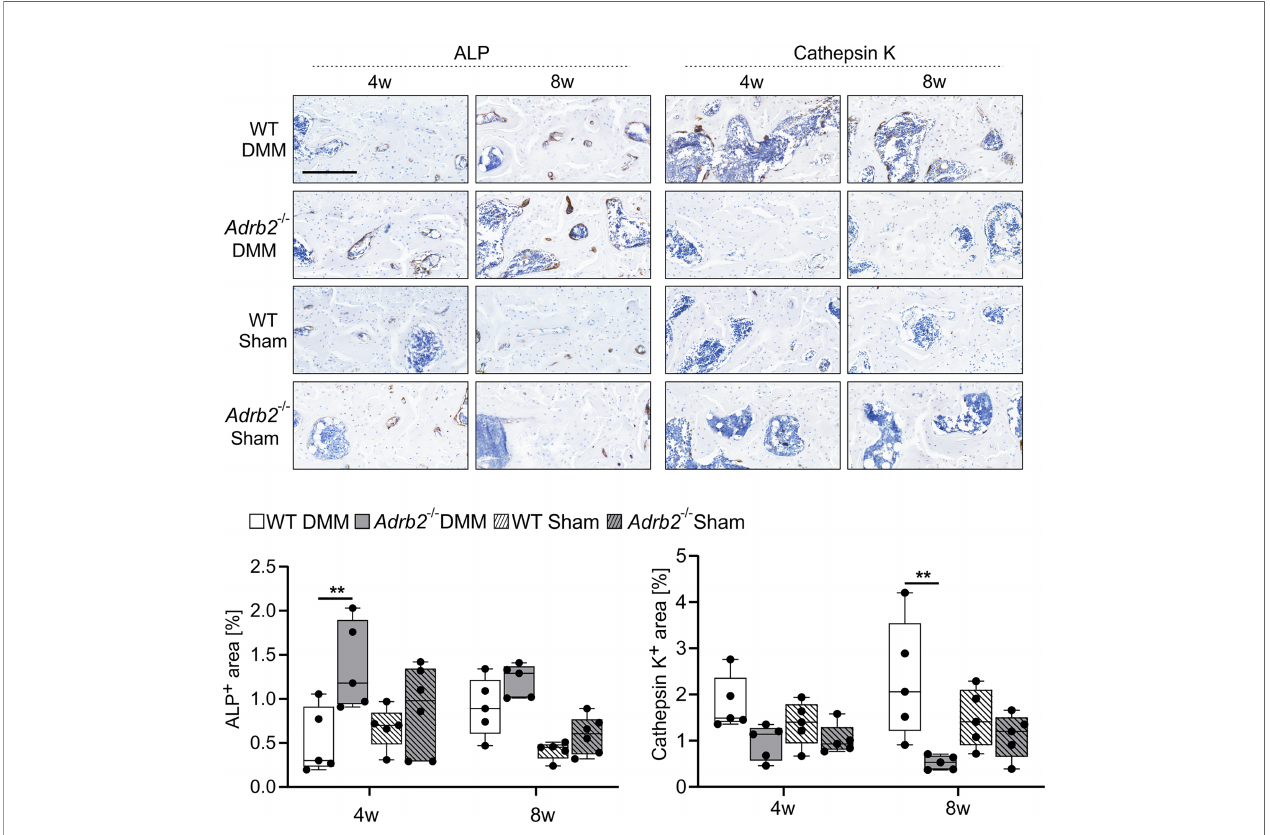
FIGURE 5 | Analysis of the osteoblast and osteoclast activity in the subhcondral bone. Immunohistochemical detection and quanti fi cation of ALP (dark brown) and Cathepsin K (dark brown) in the subchondral bone of WT and Adrb2 -/- mice 4 and 8 weeks after DMM or Sham surgery (bar: 200 µm). Nuclei are counterstained with hematoxylin (in dark blue). Data are presented as box plots with whiskers. Each black circle represents an individual mouse (n=5 per group). Signi fi cant p-values are presented as **p ≤ 0.01 for comparisons between